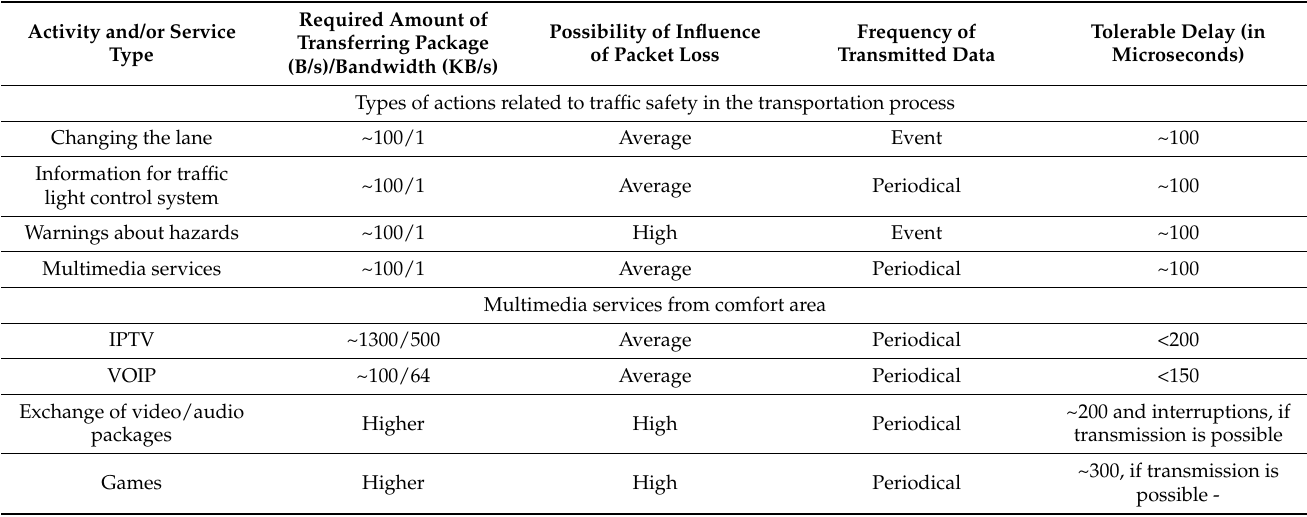
Table 4. The assessment of the data transfer parameters needed for the experiment on the heterogeneous service provision in vehicular communication